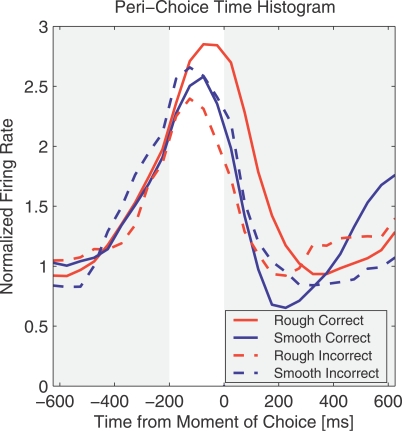
Average Normalized Firing Rate as a Function of TextureFiring rates were aligned to the moment of choice (0 ms) and binned in a sliding 250-ms window, centered on each data point. Each cluster's firing rates were divided by the recording session mean rate (note the value of 1.0 before whisker contact, at −600 ms), then the average was calculated across all clusters. The unmasked area, from −200 to 0 ms, shows the strongest texture coding before the rat's choice. Texture-related differences after the rat's choice were a consequence of the different actions rats performed in correspondence with each texture (e.g., turn left or turn right) and were not further analyzed.